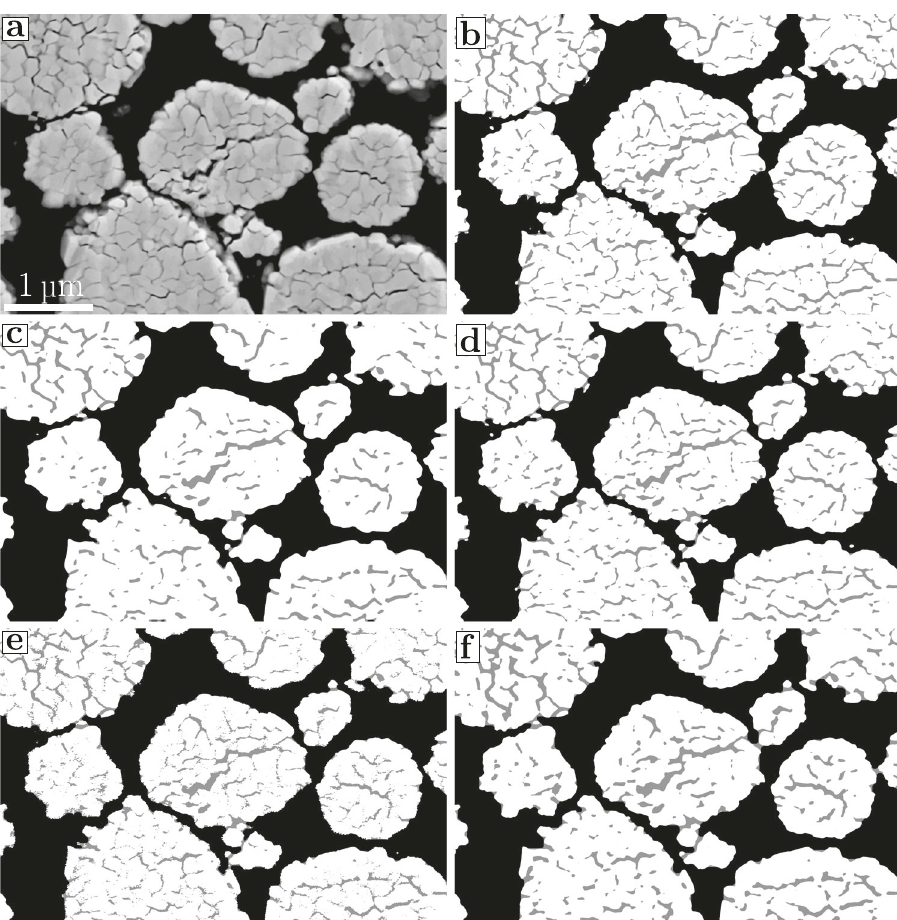
Fig. 4 Crack segmentation. High-resolution image I HR ( a ) and the corresponding segmentation map S HR computed from I HR ( b ) where black color indicates the background, gray color the cracks and white color the particles. The corresponding segmentation map b S HR computed from the upsampled low-resolution image ( c ) and from the images super-resolved by SRGAN ( d ), SRResNet2 ( e ), and CinCGAN ( f ). All fi gures use the same length